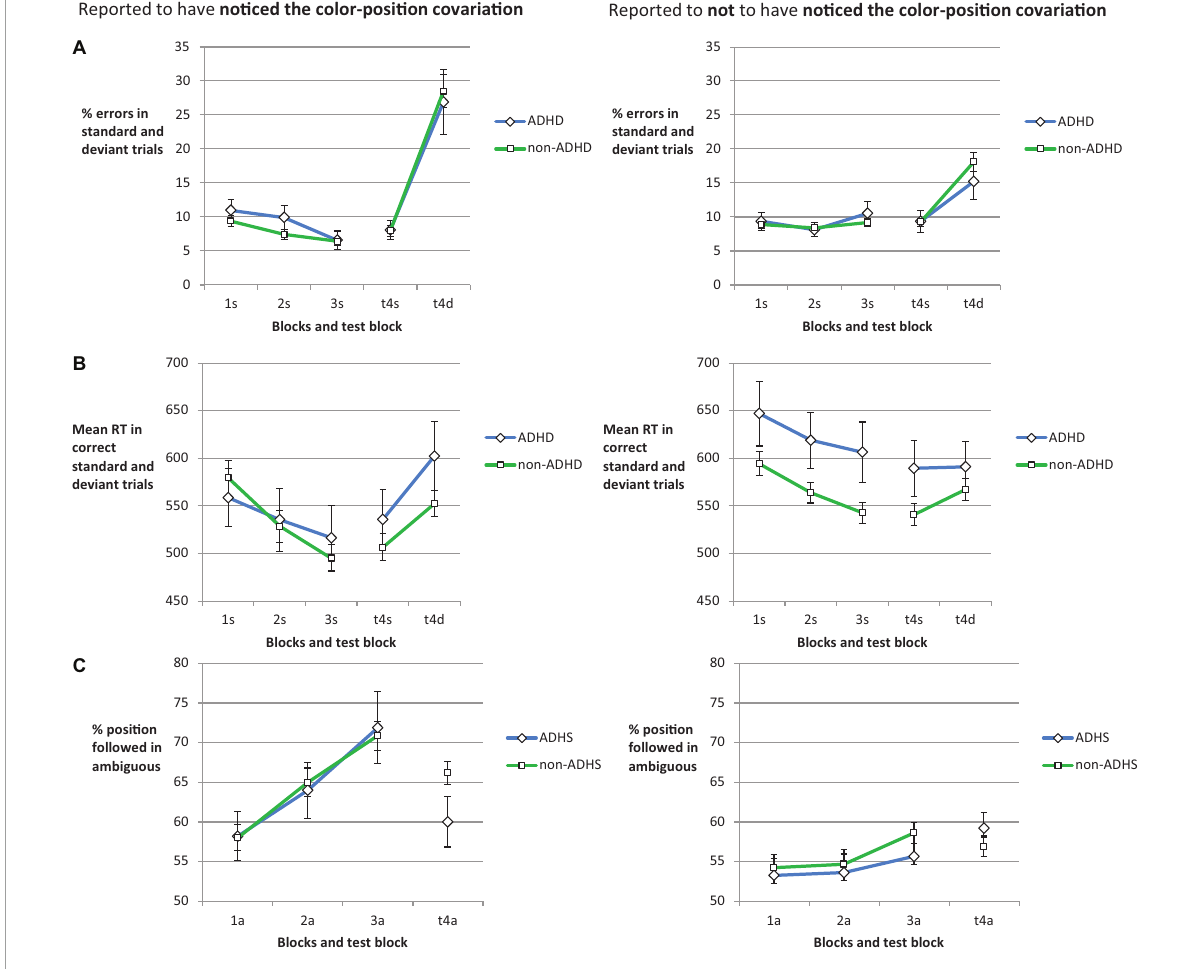
FIGURE5 For participants reporting to have noticed the color-position covariation (left column) vs. not have noticed the covariation (right column) error rate (A) and mean RT (B) are shown for standard trials for Blocks 1, 2, and 3 (practice phase), and standard and deviant trials in Block 4 (test phase). Panel (C) shows the proportion of responses in line with the color-position covariation in color-ambiguous trials. The error bars depict the between subjects SE of the mean. On the x -axis, numbers indicate the block. Letters indicate the trial type: s, standard; d, deviant; a,